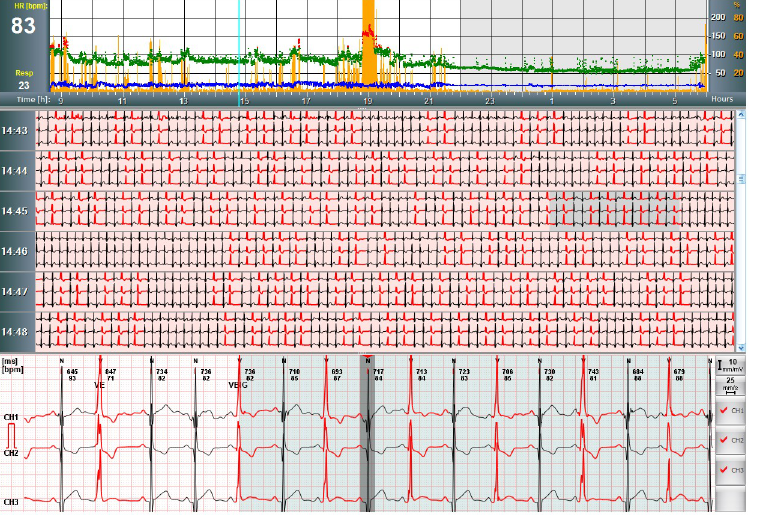
Fig 1. Premature ventricular contractions of a male referee on Holter ECG. Holter ECG recording of a 22-year-old asymptomatic male handball referee performed due to exercise induced single premature ventricular contractions. Heart rate (normal: Green, tachycardia: Red), respiration rate (blue) and movements (orange) are shown against time at the top of the figure. The high number of premature ventricular contractions (red) is presented between normal beats (black) during a resting daytime period on the middle part of the picture. A representative section of the recording shows ventricular bigeminy on the Holter ECG channels 1, 2 and 3 (modified V5, V1 and III) at the bottom. The examination revealed 9.4% single monomorphic premature ventricular contractions, numerous episodes of ventricular bigeminy and ventricular triplets. Echocardiography and CMR examinations proved to be normal. Beta- blocker therapy was initialized, and regular cardiology follow-up was indicated. Abbreviations: CMR, cardiac magnetic resonance; HR, heart rate; bpm, beats per minute; Resp, respiration; h, hour; N, normal beat; V, ventricular beat; CH, channel. Signal amplitude: 10 mm/mV, paper speed: 25